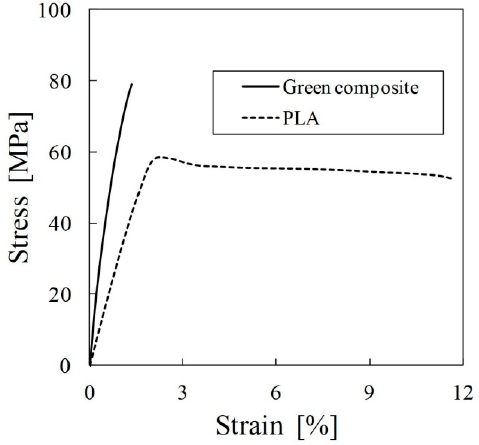
Figure 4. Stress-strain curves of green composite and PLA at 0 cycles.